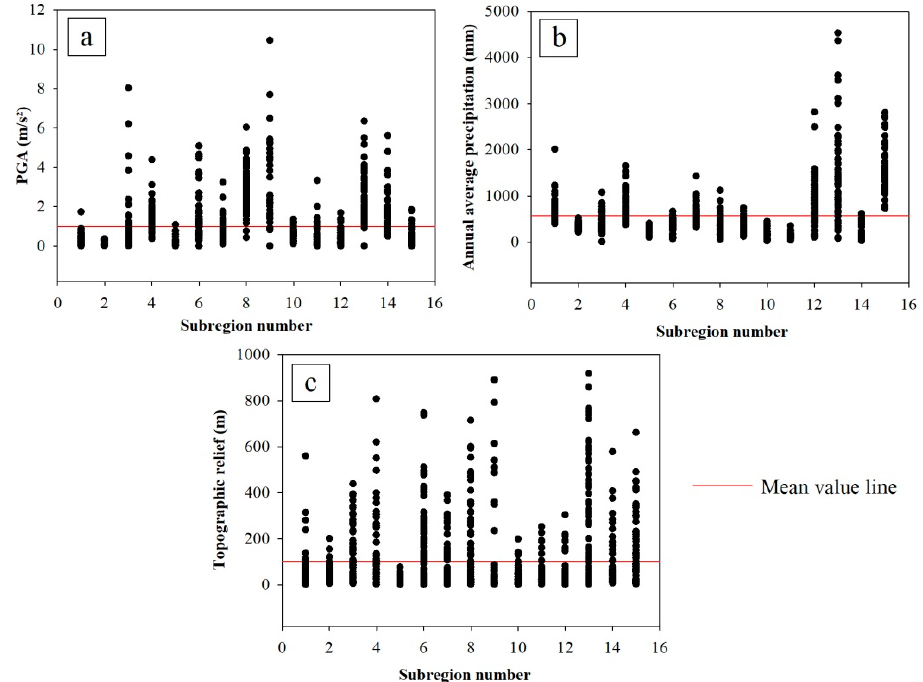
Figure 11. PPR values of random points in each subregion. ( a ) PGA (m/s 2 ), ( b ) Annual average precipitation (mm), ( c ) Topagraphic relief